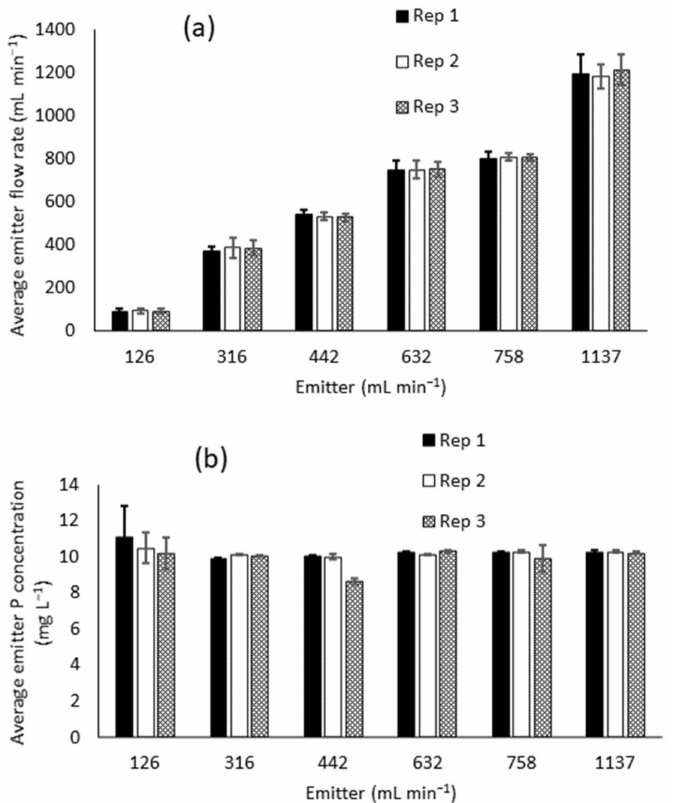
Figure 3. Average emitter flow volume ( a ) and phosphorus (P) concentration ( b ) for seven different emitters (x-axis), within a single irrigation line containing 12 emitters, connected to a Dosatron model D25F1 1:100 fixed rate injector that injected a 100 mg P L − 1 solution. The seven different emitters were “Rainbird” 2, 5, 7, 10, 12, and 18 gph (126, 316, 442, 632, 758, and 1137 mL min − 1 , respectively). Error bars indicate standard deviation at n =